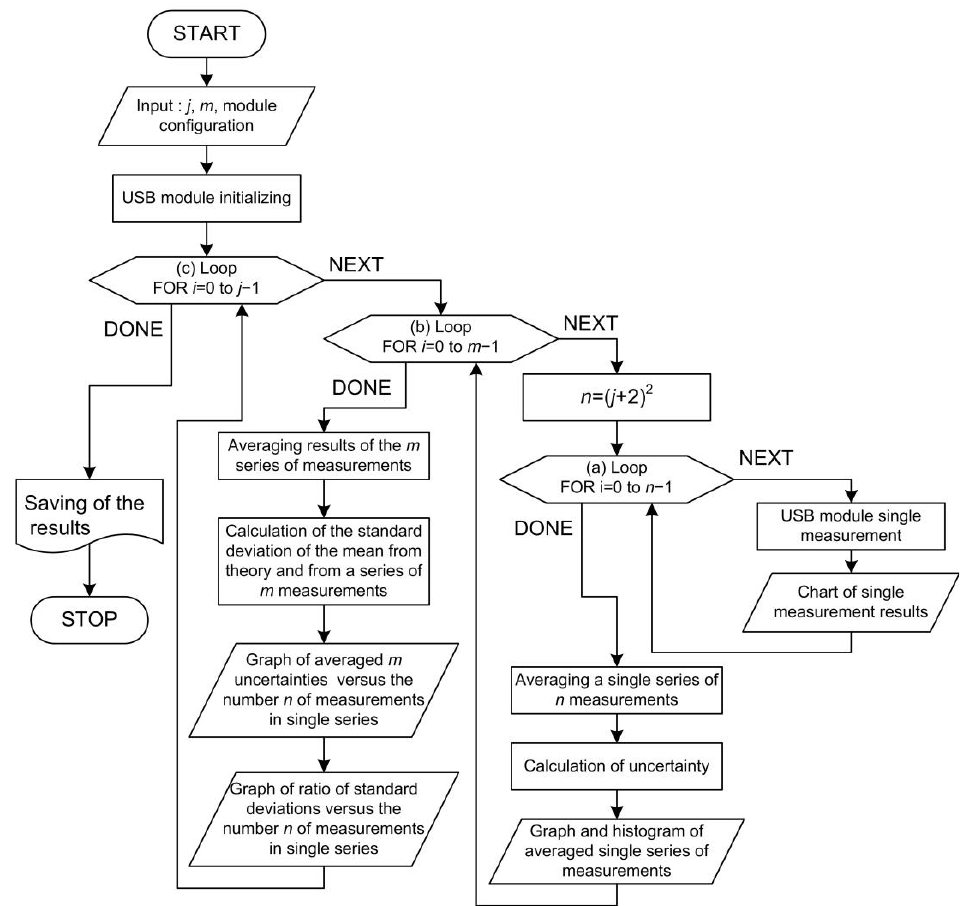
Figure 5. Flowchart of the program performing the measurements: ( a ) internal loop performing a series of single measurements; ( b ) loop repeating successive series of measurements; ( c ) main loop modifying the number of measurements in the series. It is in the form of three FOR software loops that are mutually nested in themselves. The smaller loop (a) carries out a series of n single measurements of voltage. Figure 6 shows a LabVIEW block diagram of the developed application.